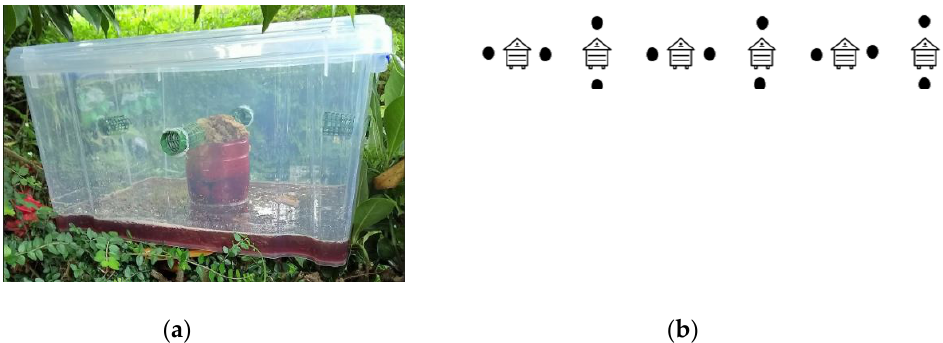
Figure 5. ( a ) The trap used to catch the Vespa velutina ; ( b ) The (black dots) show the distribution of the traps in the apiary.